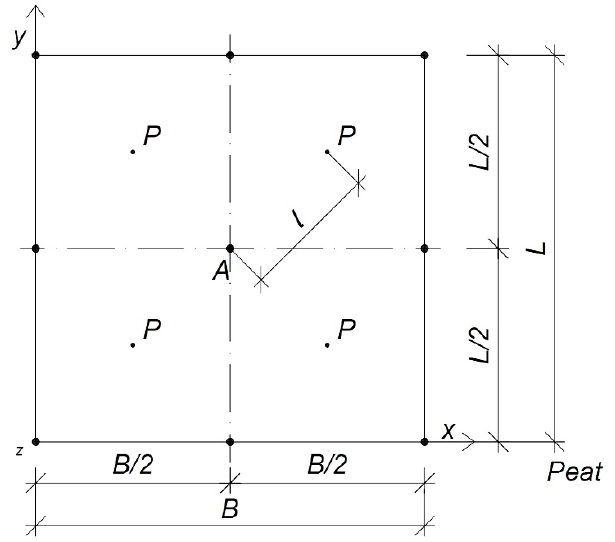
Figure 4. The division of the embankment into calculation areas for integration; top view; P , force (kN); l , distance from an analysed point to force (kN); A , analysed point ( − ); B , width of the embankment (m); L , length of the embankment (m); x , axis of width; y , axis of depth; z , axis of depth.